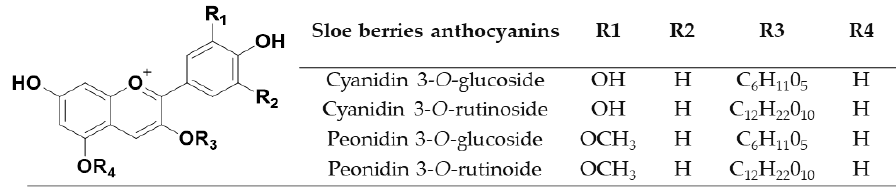
Figure 1. Structures of the di ff erent anthocyanins present in the sloe samples.